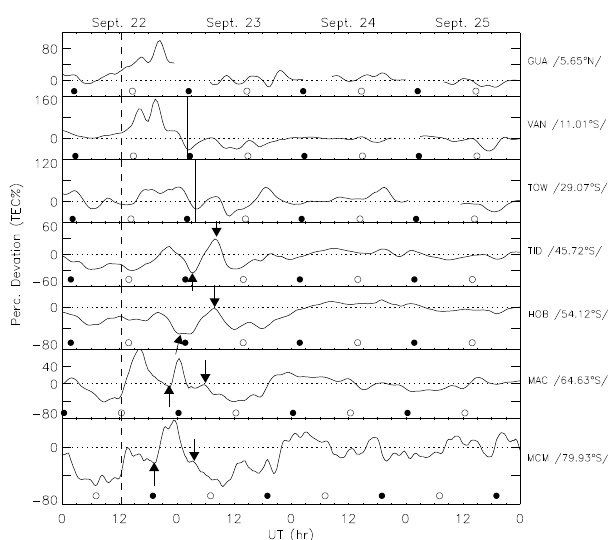
Fig. 3. Temporal profile of percentage deviation of storm time TEC, relative to quiet days (six days average), during 22–25 September at different latitudes. Vertical broken line indicates SSC. Open and solid circles on the time axis correspond to local midnight and noon,